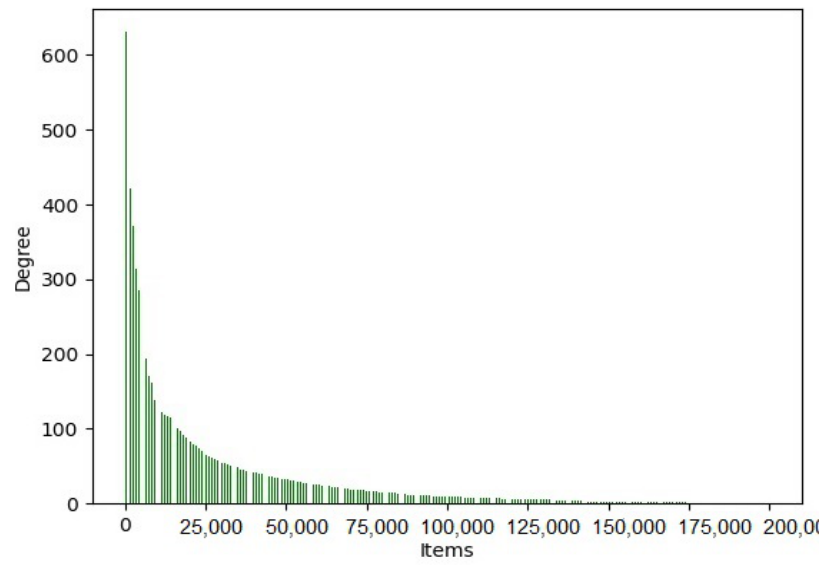
Figure 2. The distribution of item degrees in the Book-Crossing